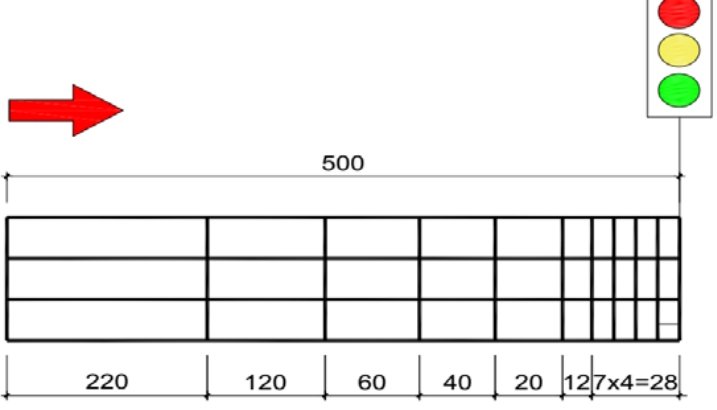
Figure 7. State space of the west arm.